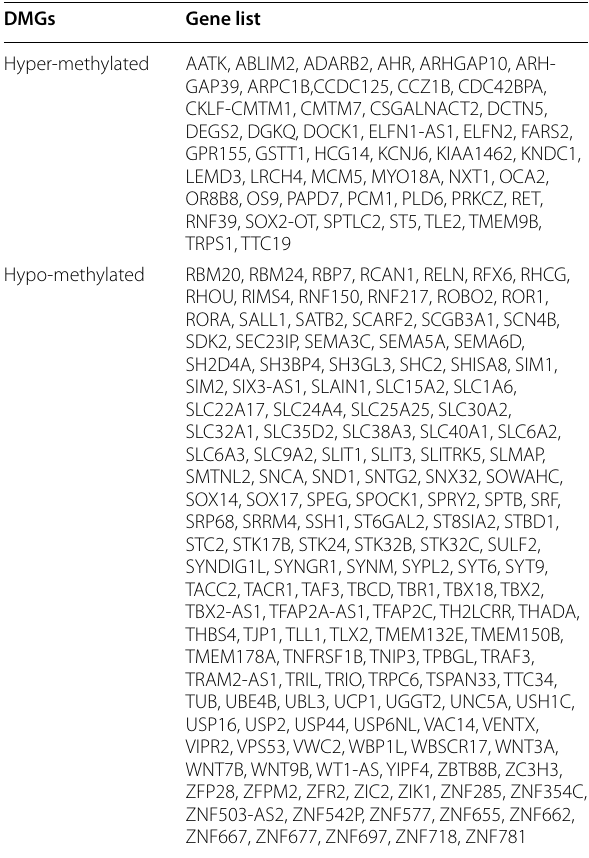
Table 1 Identified DMGs from data sets in periodontitis